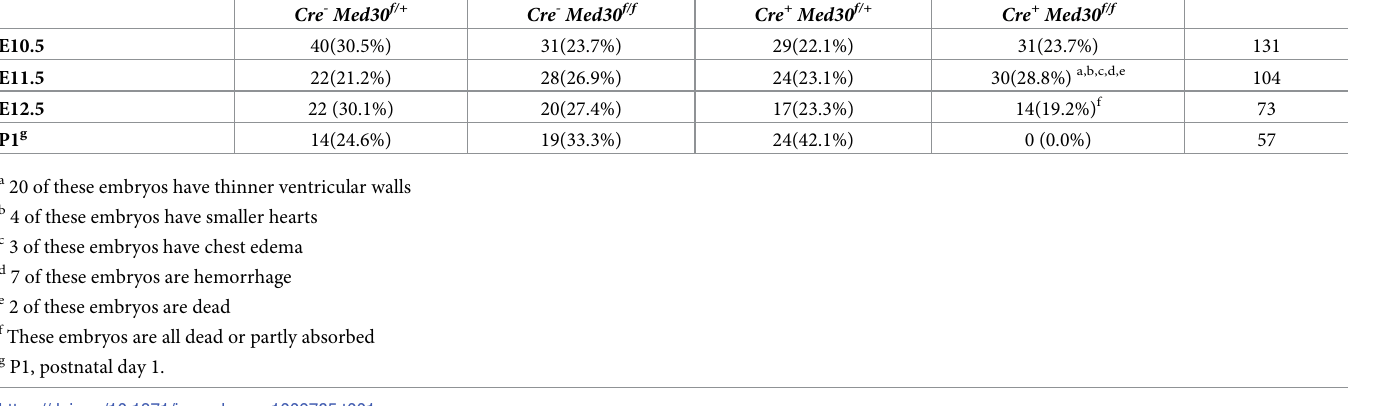
Table 1. Genotypic analysis of embryos from Cre + Med30 f/+ male cross with Cre - Med30 f/f female. Day of